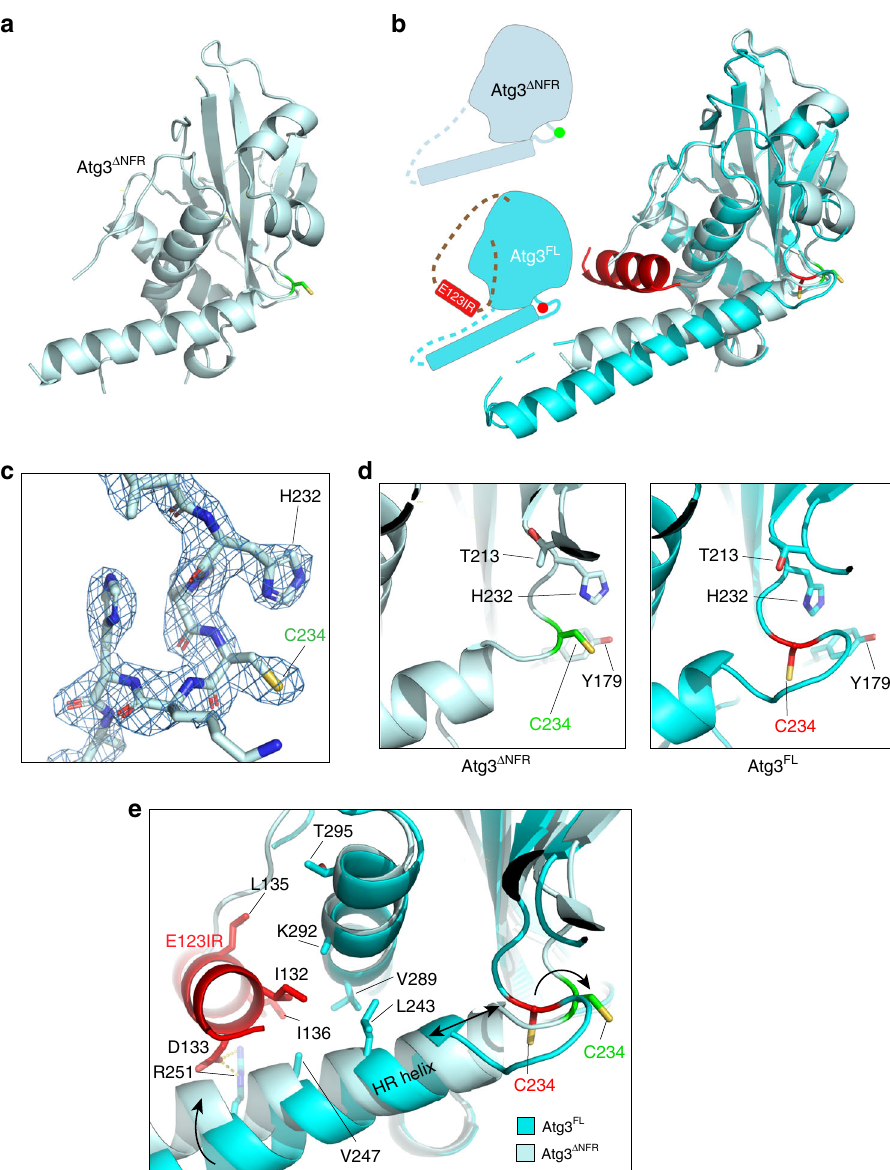
Fig. 5 Conformational changes upon E123IR removal from Atg3. a Crystal structure of Atg3 Δ NFR (PDB 6OJJ, from this study). b Superposition of Atg3 Δ NFR (PDB 6OJJ, light blue with catalytic Cys shown in green) with prior structure of Atg3 FL (cyan, PDB 2DYT) with E123IR and catalytic Cys shown in red, and differences highlighted in cartoons. c Fo – Fc map shown at 3 σ after omitting the catalytic cysteine region (residues 231 – 237) of Atg3 Δ NFR and performing simulated annealing. d Close-ups of catalytic elements from Atg3 Δ NFR and Atg3 FL . e Close-up superposition of Atg3 Δ NFR (light blue) and Atg3 FL (cyan) structures, showing interactions between Atg3 ′ s catalytic domain and E123IR, and conformational rearrangements upon E123IR